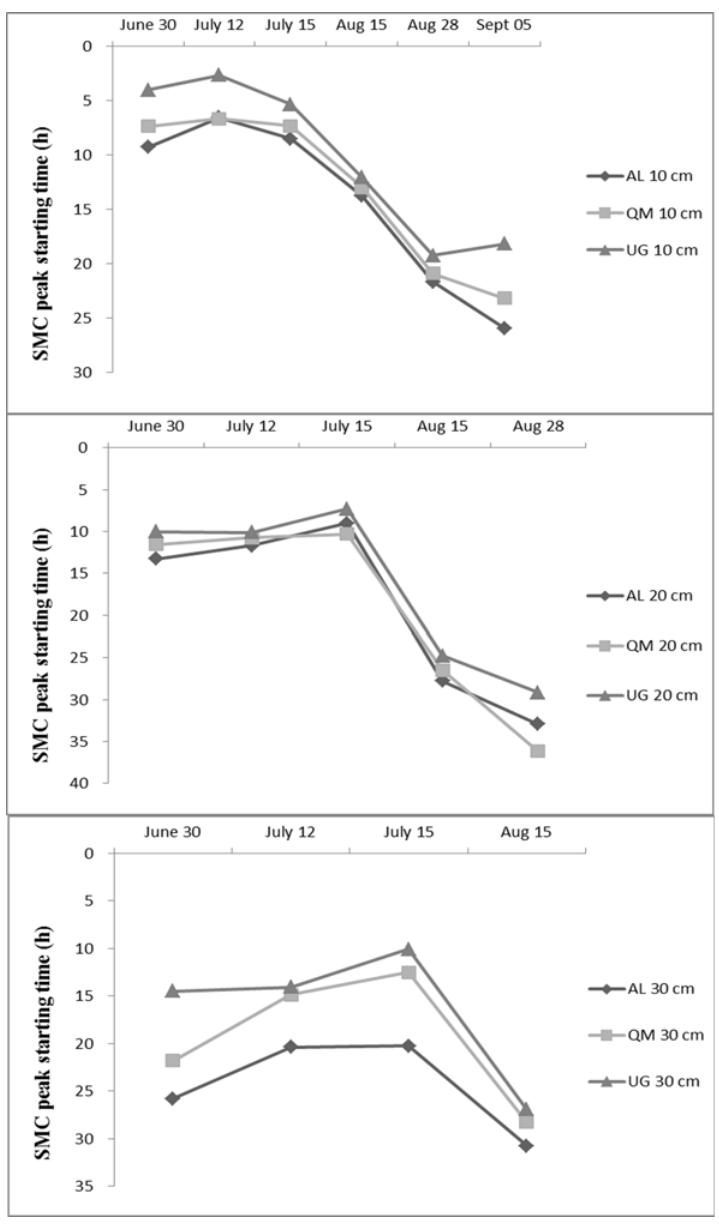
Fig 3. The onset of peak soil-moisture content (SMC) at each soil depth for the three vegetation types for individual rains. Notes: AL, artificial Larix spp.; QM, Quercus mongolica ; UG, unused grassland.